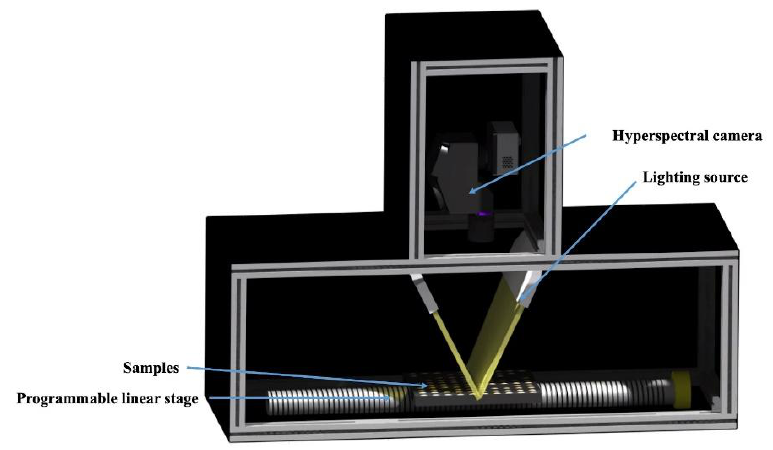
Figure 1. Schematic of the hyperspectral imaging system.